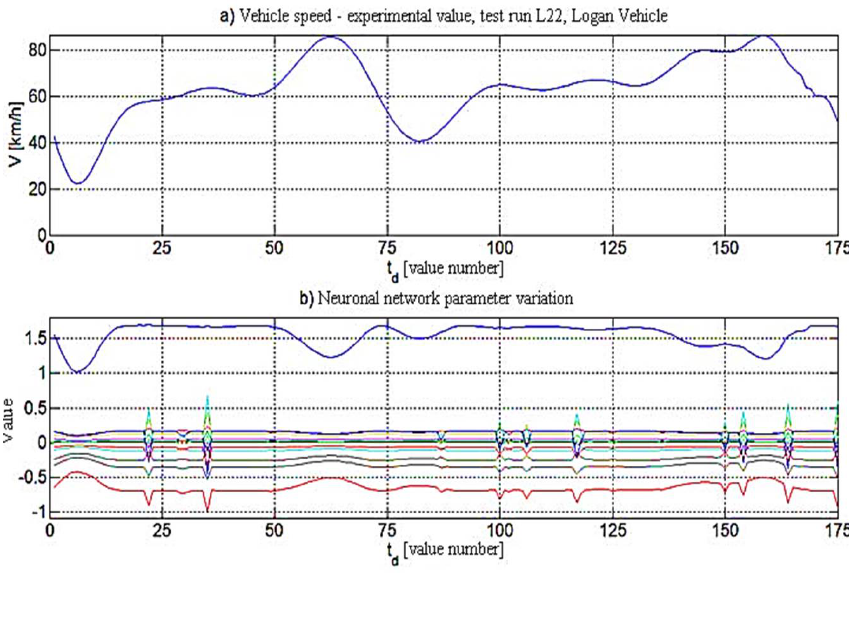
Figure 6. Neuronal network dynamics.